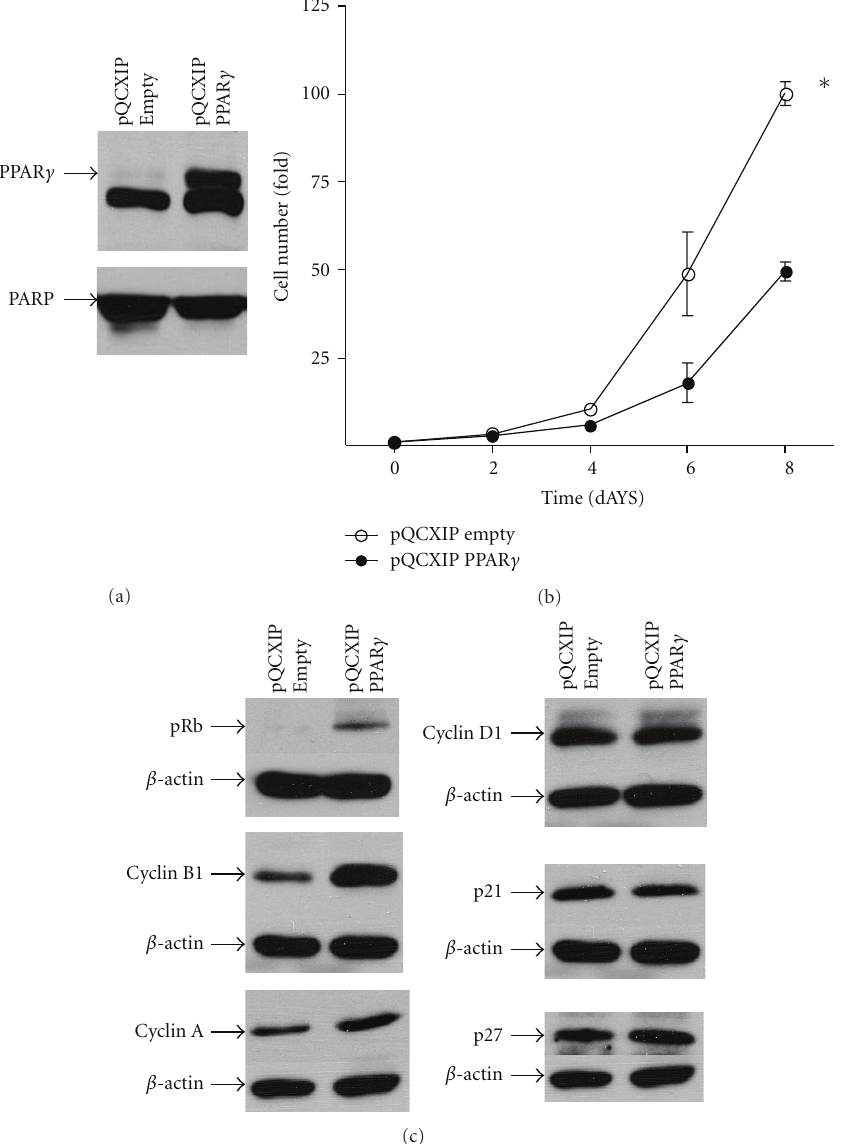
Figure 6: E ff ect of PPAR γ overexpression on the growth characteristics of BCPAP cells. (a) 40 μ g of nuclear extract protein from BCPAP cells transfected with either pQCXIP (empty) or pQCXIP-expressing PPAR γ was separated on a 10% SDS-PAGE gel, transferred to PVD, probed with PPAR γ antibodies (sc-7196), and reprobed with PARP as described in Figure 2(a). (b) Cell growth rate was assessed by counting viable BCPAP cells transfected with pQCXIP (empty) or pQCXIP-expressing PPAR γ at 2-day intervals. Data is represented as fold cell number over day 0 (5 expts. ± SEM; ∗ , P < 0 . 001 at day 6, P < 0 . 0001 at day 8 by 2-way ANOVA). (c) 50 μ g of total cellular protein from BCPAP cells transfected with pQCXIP (empty) or pQCXIP-expressing PPAR γ was separated on a 10% SDS-PAGE gel, transferred to PVD, and probed with antibodies against the corresponding cell cycle protein followed by the appropriate secondary antibody as described in Figure 4. β -actin was quantitated as a loading